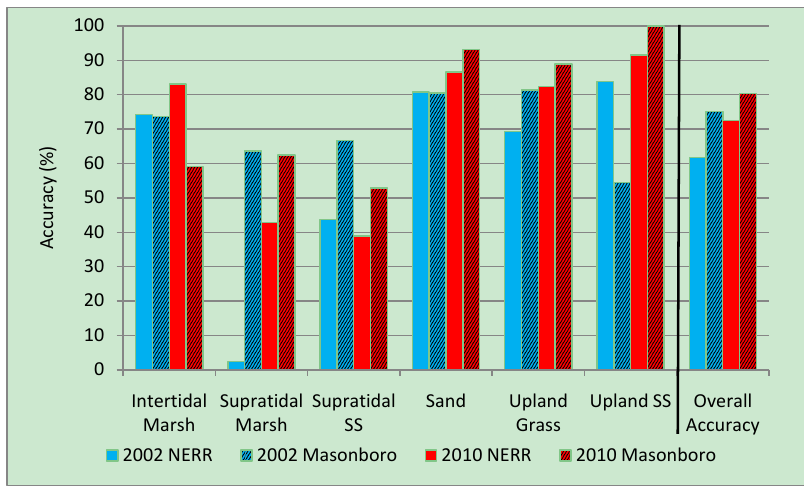
Figure 8. Habitat class accuracies for the best maps for 2002 and 2010 for both the NERRS study area and Masonboro